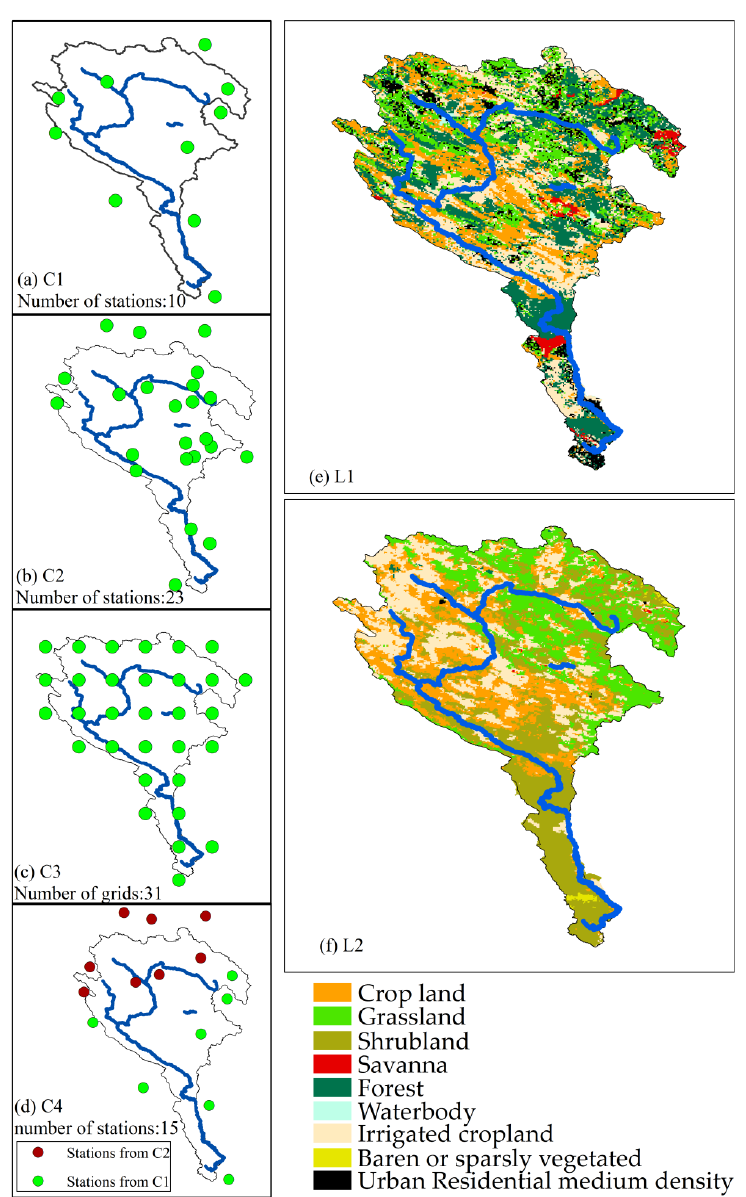
Figure 2. ( a – d ) The location of climate station in the four sources of climate data C1, C2, C3, and C4. ( e , f ) The land use classifications in the L1 and L2 maps.